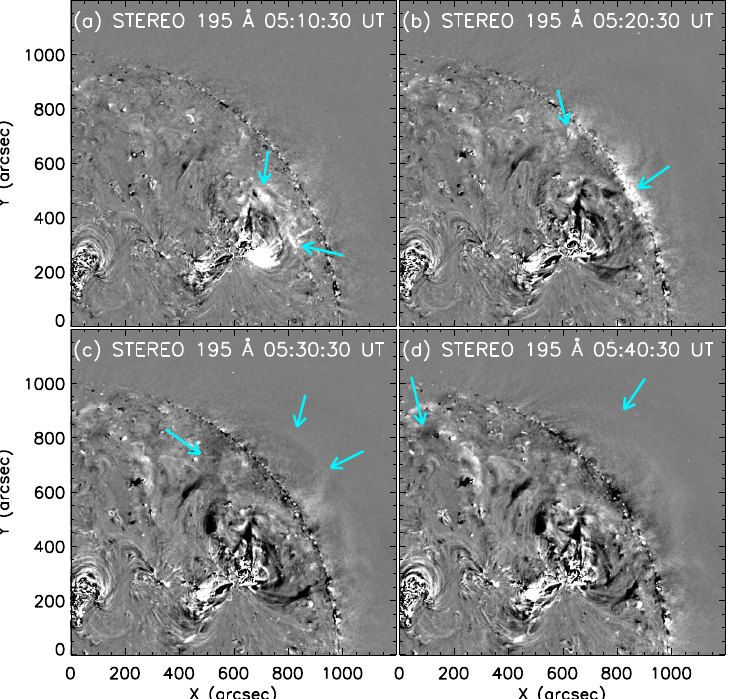
Figure 3. Evolution of the base difference images in STEREO-A 195 Å showing the wave propagation. The base image is selected at 04:50:30 UT. The cyan arrows indicate the propagation of the wave.